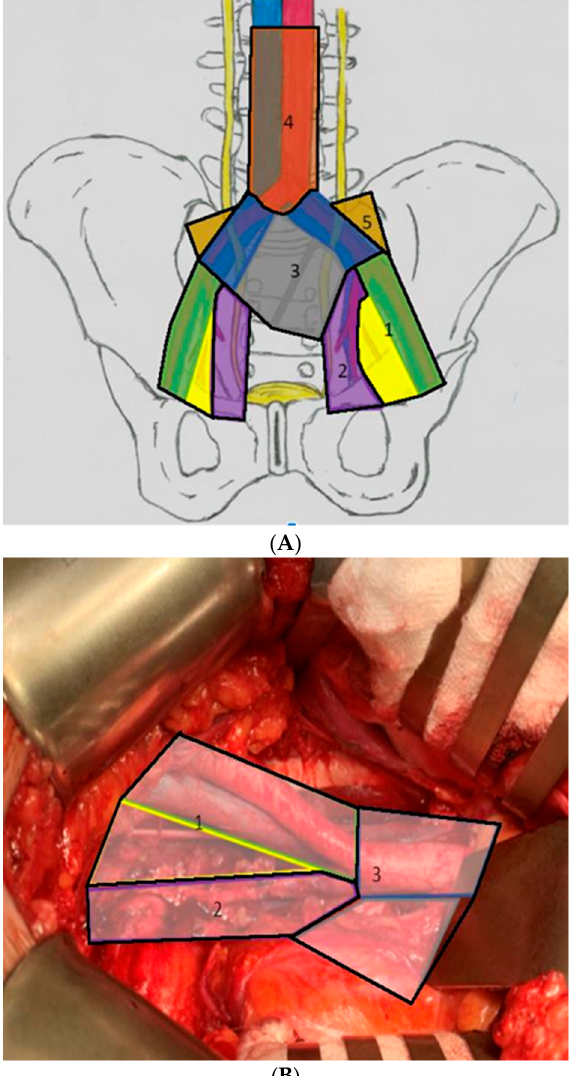
Figure 1. Anatomical extent of lymphadenectomy: 1—limited; 2—standard; 3—extended; 4—super- extended; 5—Marcille’s Fossa; ( A )—topography; ( B )—anatomical superimposing. The limited PLND (lPLND) engages the obturator fossa area LN only (located medio- caudally to the external iliac vein, atop the tendinous arch of the levator ani muscle and internal obturator muscle), while the standard PLND covers the obturator and external iliac nodes (proximally located along or between external iliac vessels, distally next to the deep inguinal ring, crossed by the deep circumflex iliac vessels) [50,51]. The extended PLND (ePLND) consists of lymph node groups covered by the standard procedure as well as additional ones, such as hypo-gastric, pre-sacral (along the sacral concavity), internal, and common iliac nodes (stretching on the common iliac vessels before the aortic bifurcation) [51,52]. Salvage extended PLND is recommended in recurrent prostate cancer, with the additional removal of inter-iliac and para-aortic LN [48,53]. The total number of nodes removed is crucial to maintain the accuracy of the staging